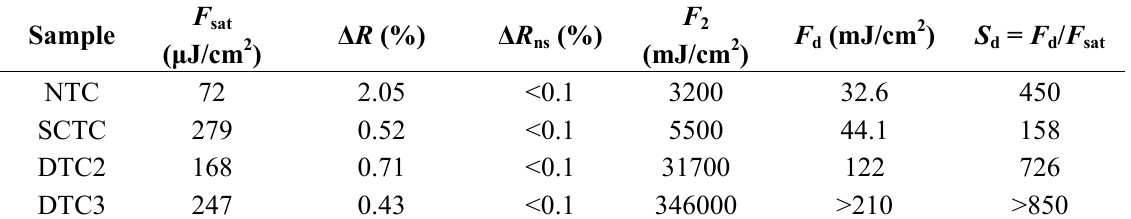
Table 3. Damage thresholds of the different representative SESAMS together with their saturation parameters. The samples with a 3-pair dielectric topcoating did not show damage up to the maximum available fluence in our setup of 0.21 J/cm 2